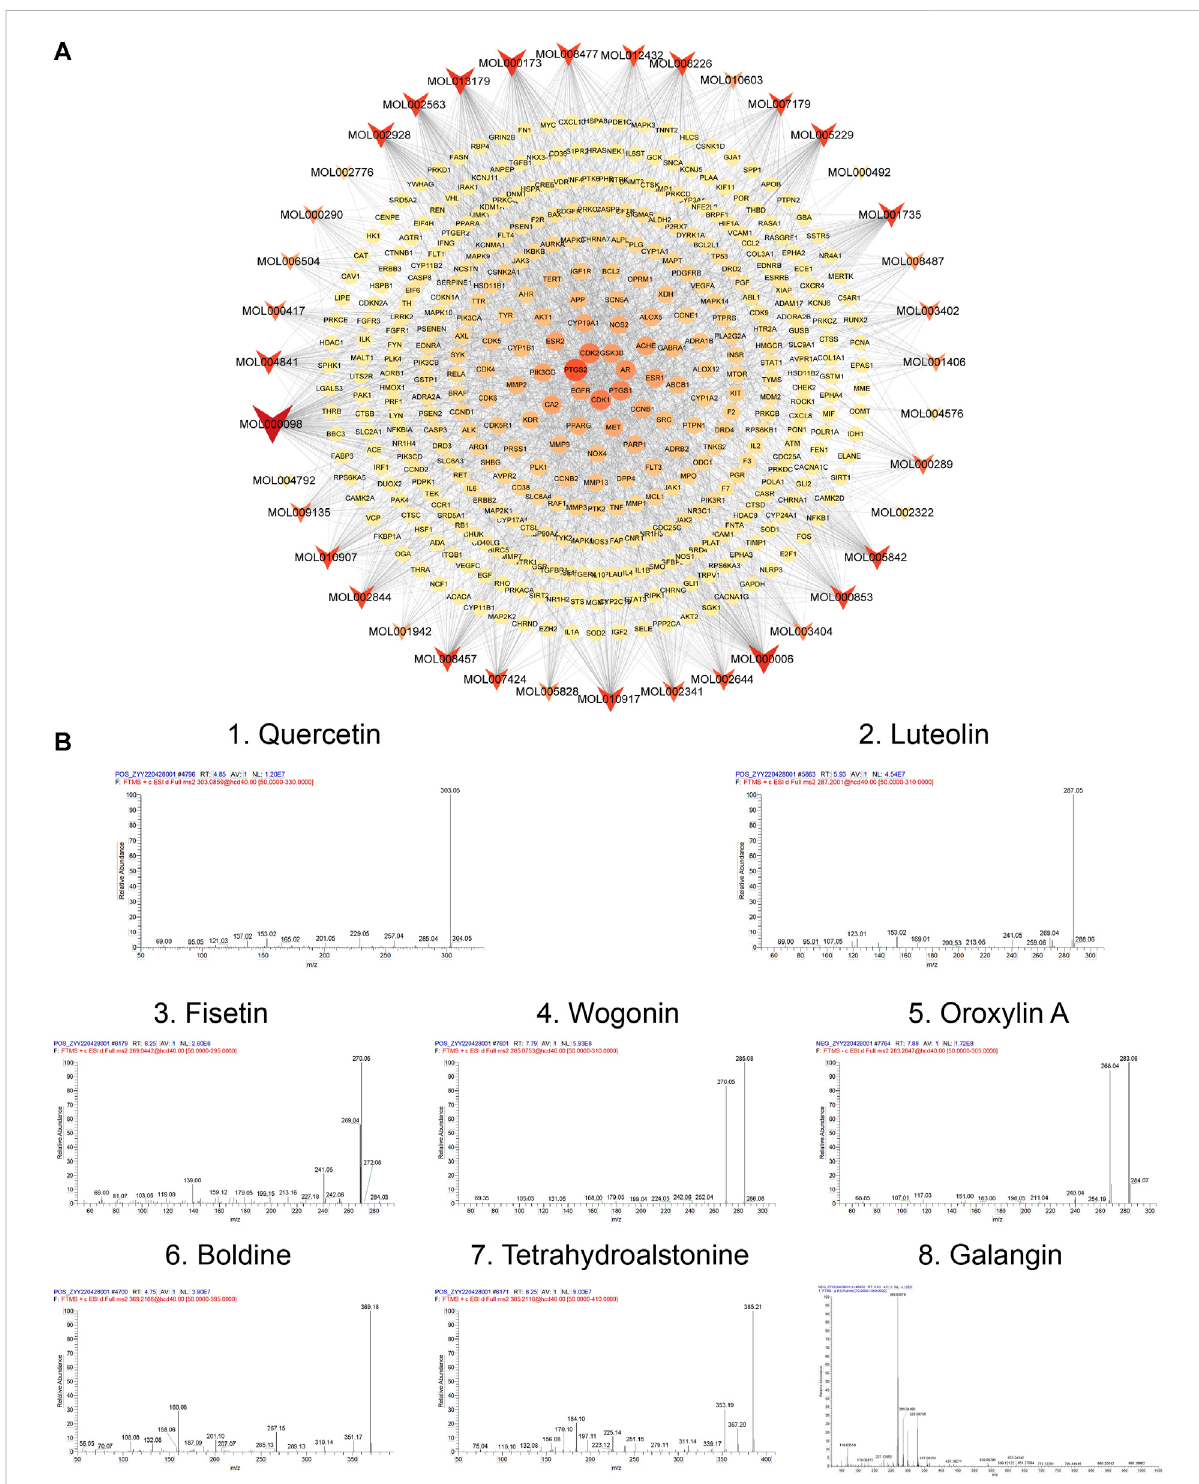
FIGURE 5 Network and Mass spectra analysis. (A) Bioactive component-target network. The ellipse nodes represent the overlapping gene targets between the alopecia disease and TGD. The triangle nodes are composed of bioactive components in TGD. The size and color depth of node were correlated with degree-value. (B) Mass spectra of the core components in